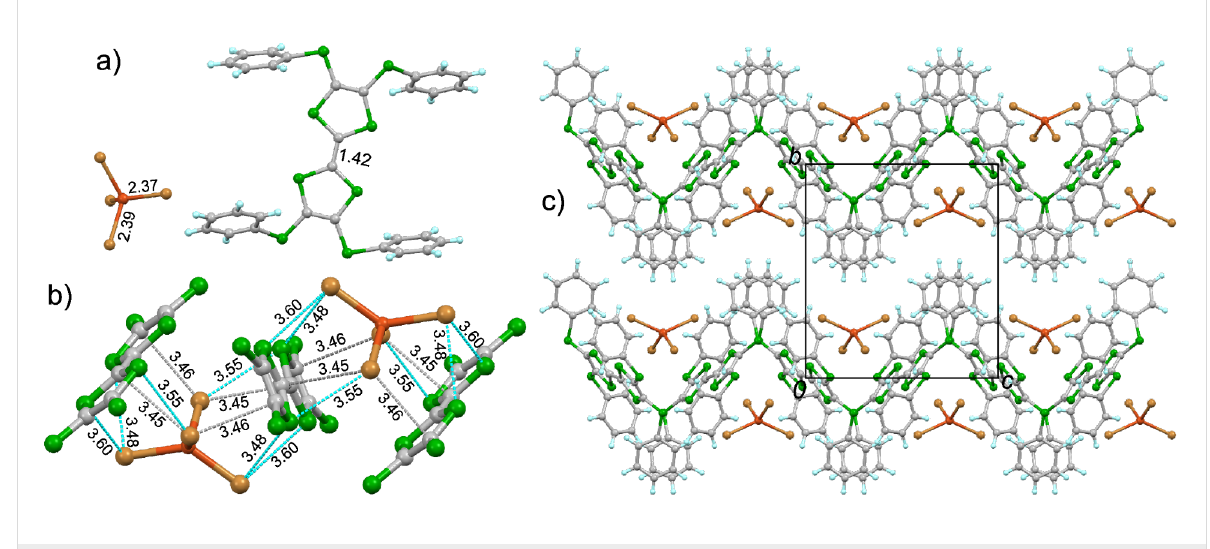
Figure 1: Crystal structure of 1 ·CuBr 4 : a) unit cell contents with the typical bond lengths shown (in Å); b) interactions between the [Cu(II)Br 4 ] 2 − ion and the central TTF core of 1 , where the cyan and grey dashed lines represent Br ··· S and Br ··· C contacts (Å), respectively; c) packing structure viewed along the a